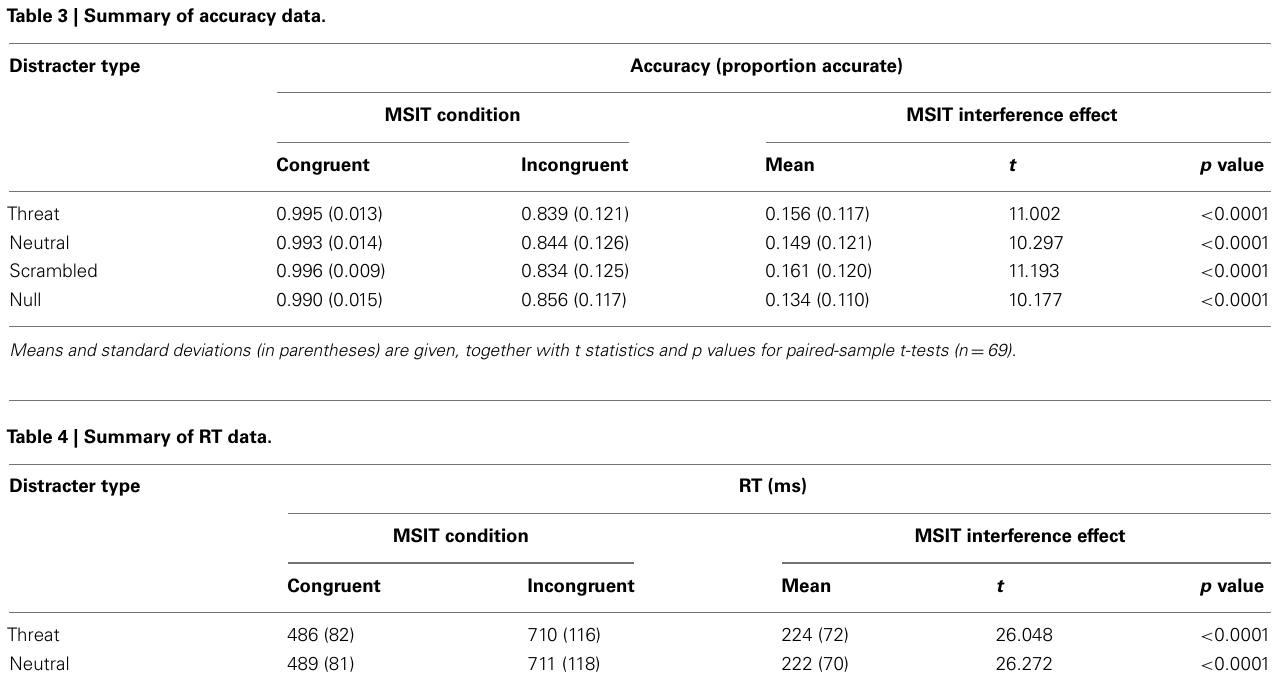
Table 3 | Summary of accuracy data.